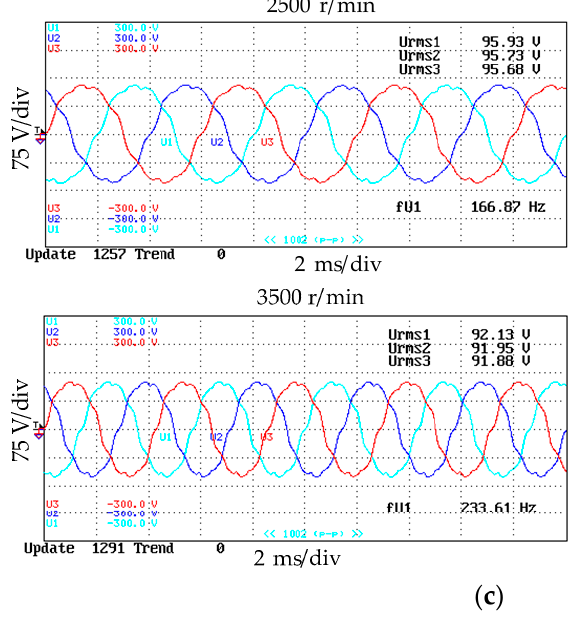
Figure 24. The validity test of the NMC according to the no-load back EMF test (the speed-up process): ( a ) the no-load back EMF test; ( b ) the no-load air-gap magnetic flux density test; ( c ) the no-load back EMF waveforms at different speeds.